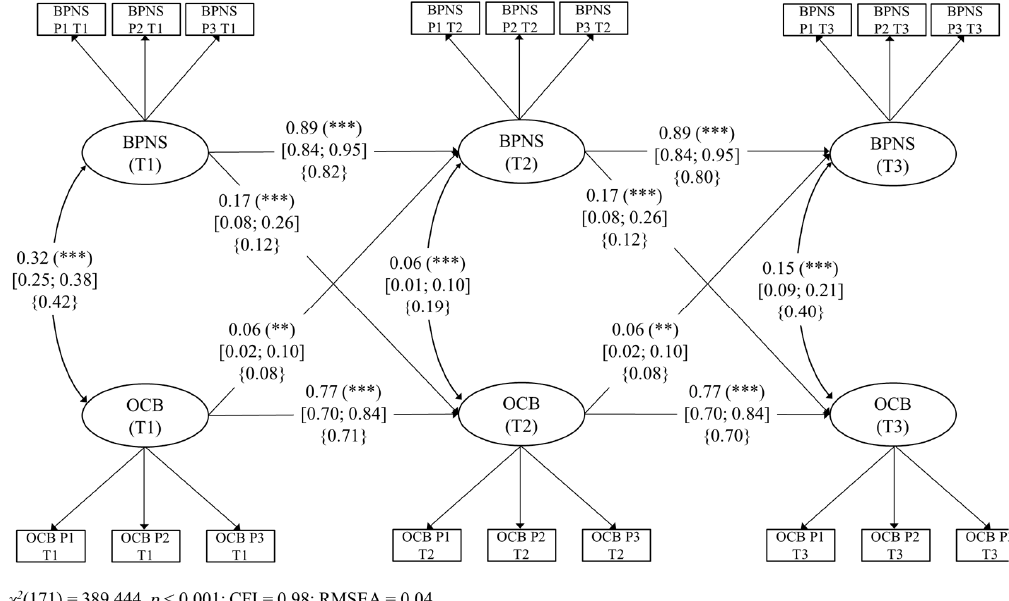
Figure 2. Model 2. Structural longitudinal model for the associations between basic psychological need satisfaction (BPNS) and organizational citizenship behaviors (OCBs). Coefficients shown are unstandardized paths. The unstandardized confidence intervals are reported in square brackets for significant paths. Standardized paths are shown in curly parentheses. Error terms and loadings are not shown to enhance visual clarity. P1: Parcel 1, P2: Parcel 2, P3: Parcel 3, and P4: Parcel 4. T1: Time 1, T2: Time 2, and T3: Time 3. Solid lines = significant paths. *** p < 0.001; ** p < 0.01.